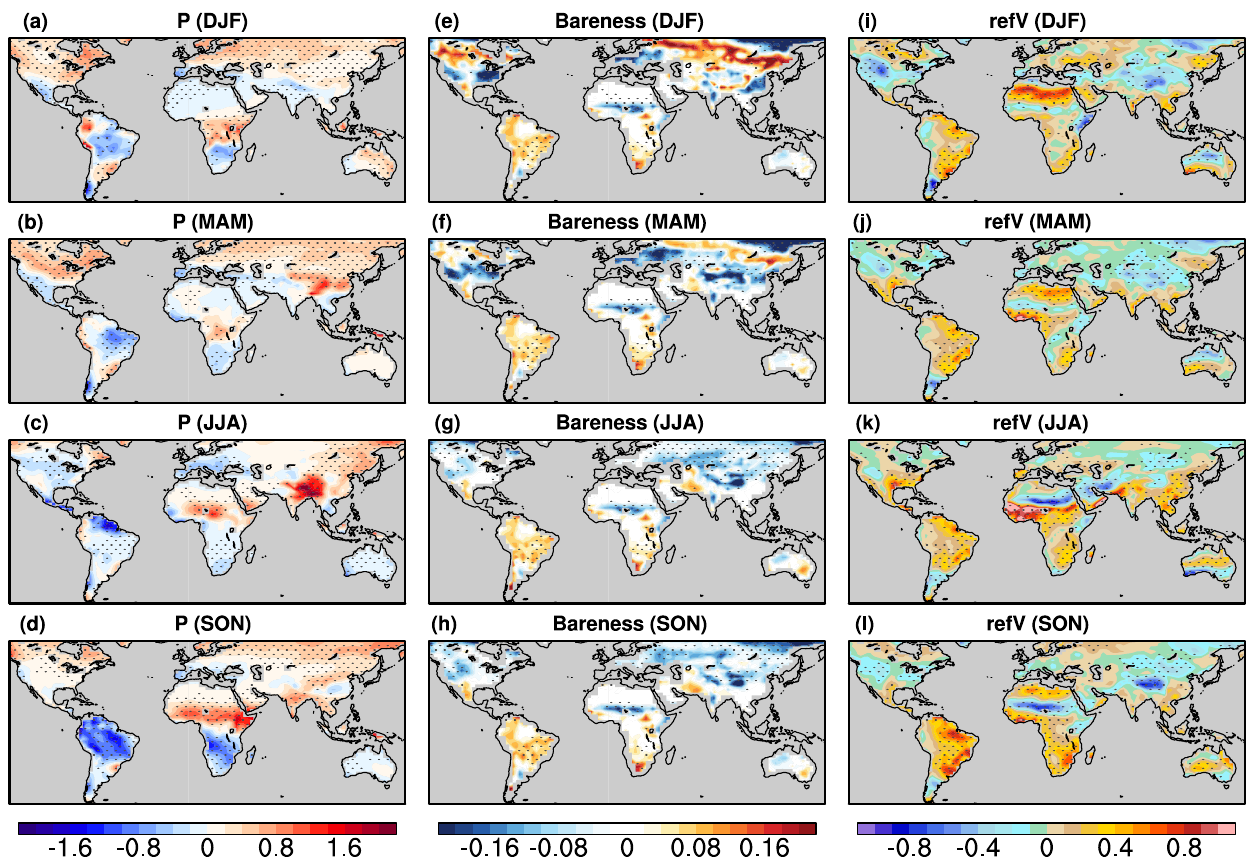
Figure 8. Projected difference of (a–d) precipitation (mmd − 1 ), (e–h) bareness, and (i–l) 10m wind (ms − 1 ) between the late half of the 21st century (2051–2100; RCP8.5 scenario) and historical levels (1861–2005) from the multi-model mean of seven CMIP5 models. Areas with sign agreement among the models reaching 71.4% (i.e., at least five out of seven models have the same sign as the multi-model mean) are